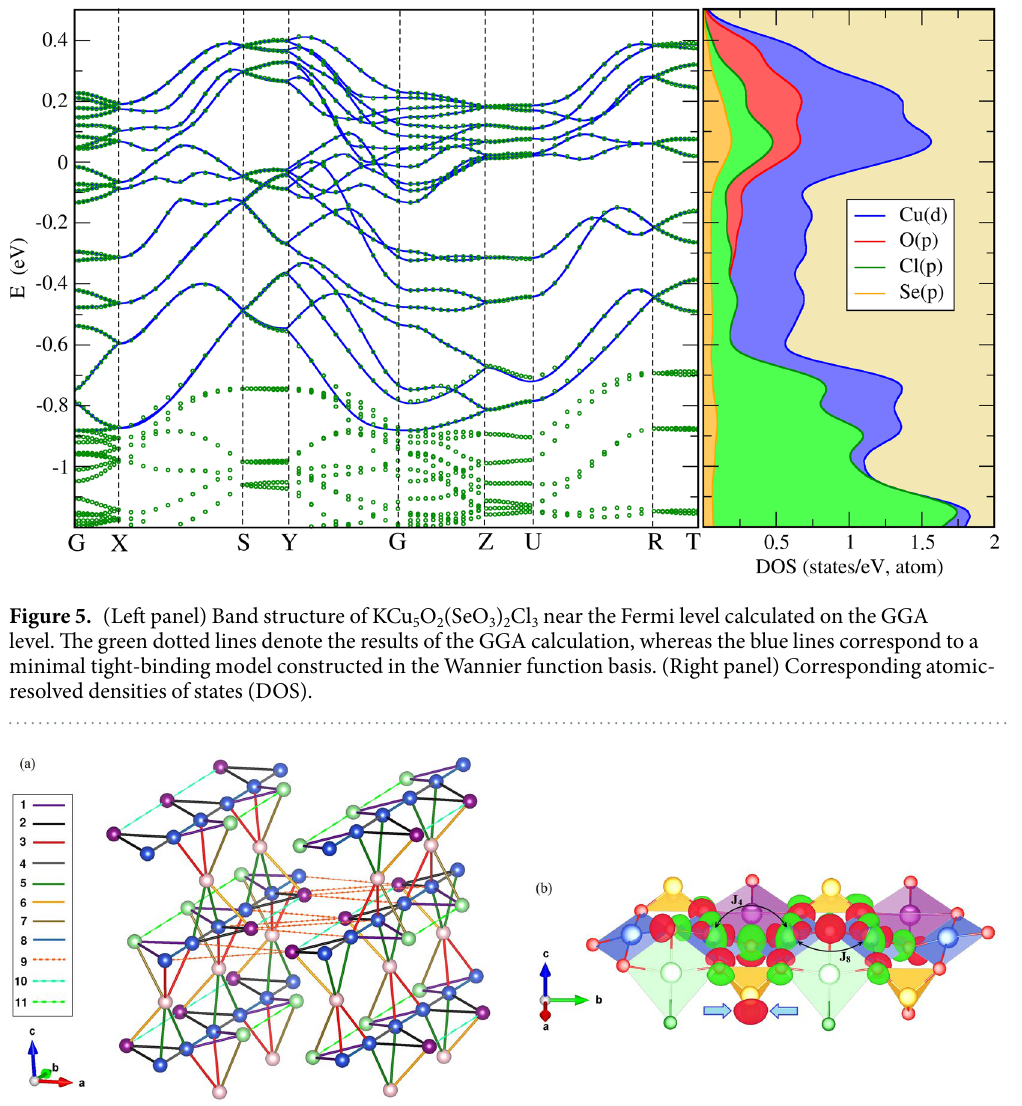
Figure 6. ( a ) Schematic representation of magnetic interactions between the copper atoms in the KCu 5 O 2 (SeO 3 ) 2 Cl 3 structure. ( b ) Wannier functions centered on copper atoms within the structural chain. The blue arrows indicate the sizable overlap of the Wannier functions at the Se sites, the effect that underlies the large difference between J 4 and J 8 . Different colors denote different phases of the Wannier